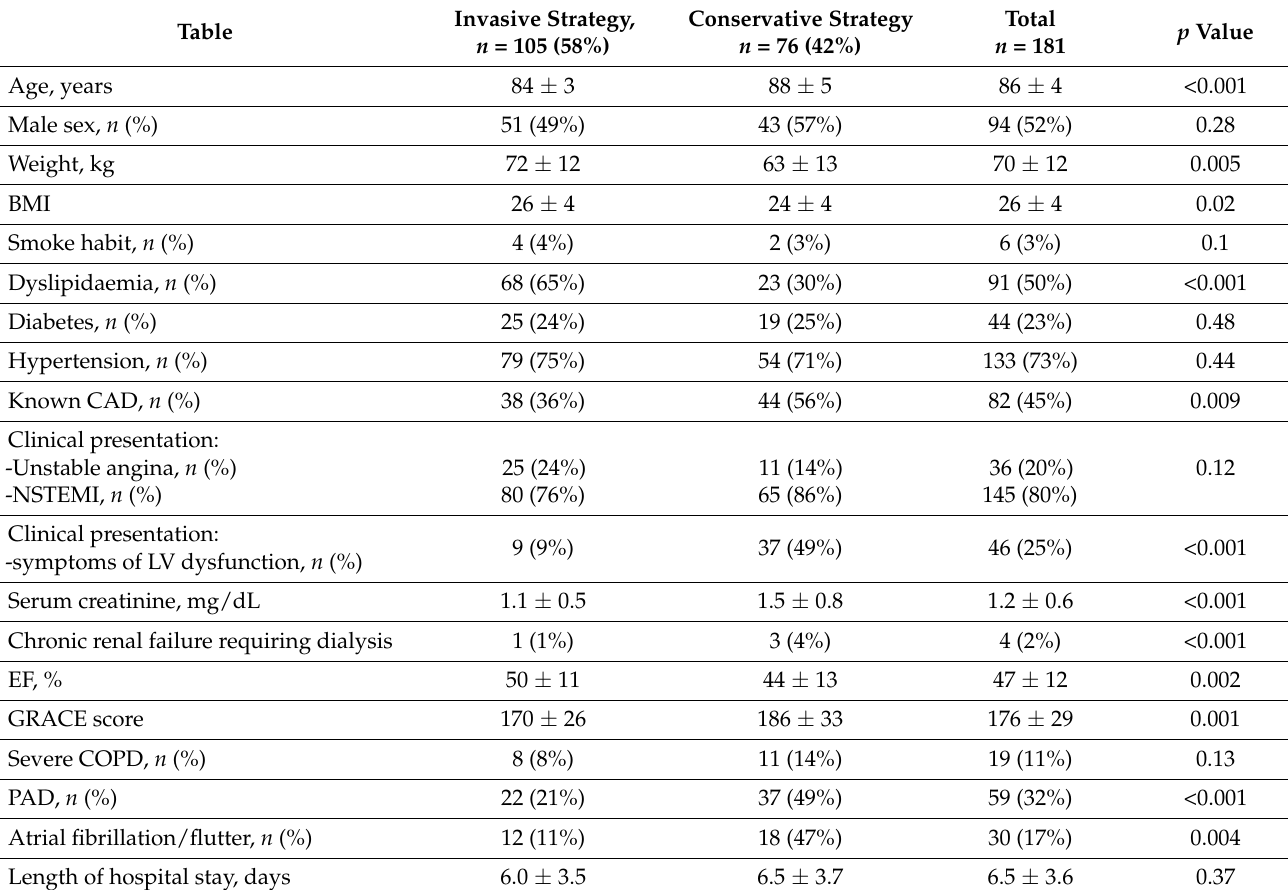
Table legend: BMI (body mass index); CAD (coronary artery disease); NSTEMI (non-ST elevation myocardial infarction); LV (left ventricle); EF (ejection fraction); COPD (chronic obstructive pulmonary disease); PAD (peripheral-artery